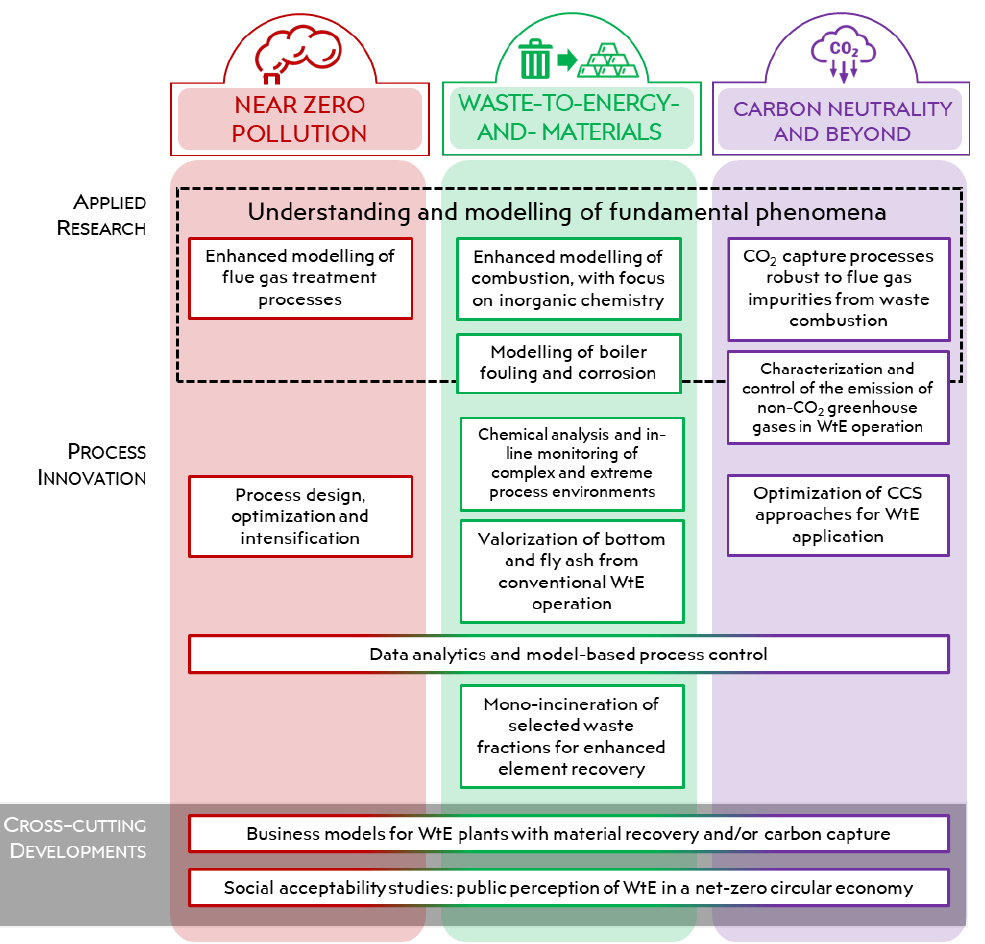
Figure 1. Research and innovation needs discussed in the present paper for the transition of waste-to-energy into a capstone for a net-zero circular economy.